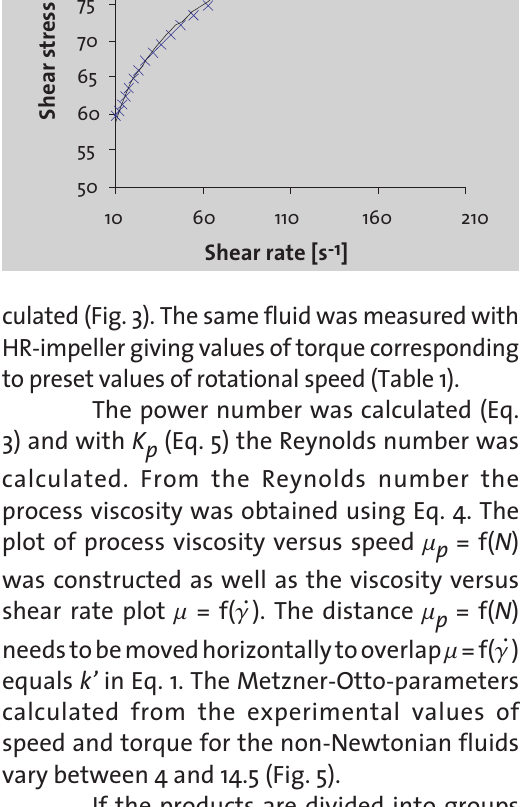
Figure 2 (left): Power curve for the HR impeller-vessel arrangement. Figure 3 (right): Experimental values for shear rate and shear stress obtained by standard geometry for Liebig Pur Soupe Veroulé.